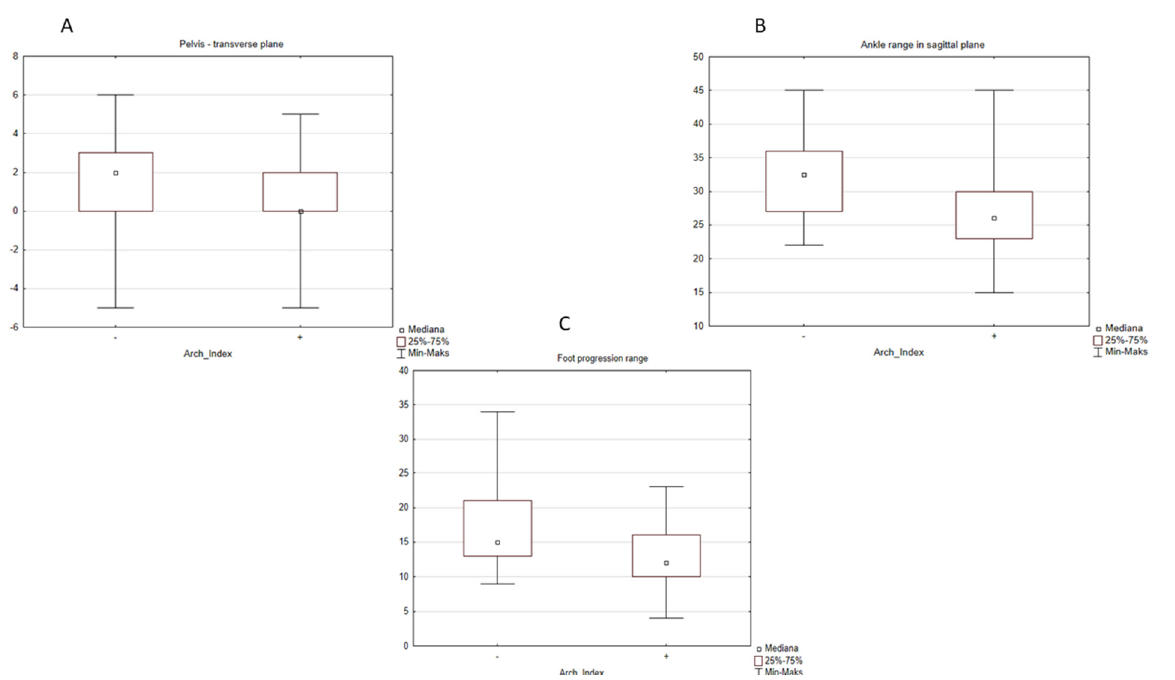
Figure 4. The influence of the type of the foot defined by the Arch Index on the kinematics: ( A ) pelvic rotation in transverse plane, “-“ normal foot (median = 2.0), “+” flat foot (median = 0.0). ( B ) Ankle range in sagittal plane, “-“ normal foot (range = 32.5), “+” flat foot (median = 26.0), and ( C ) the foot progression range, “-“ normal foot (median = 15.0), “+” flat foot (median = 12.0).